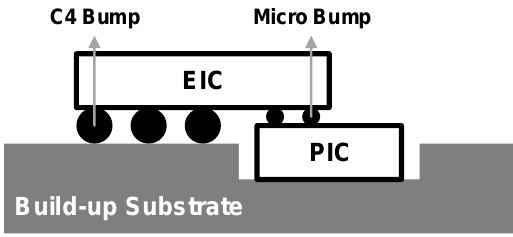
Figure 16. Flip-chip bonded EIC directly on PIC using micro bump [56].